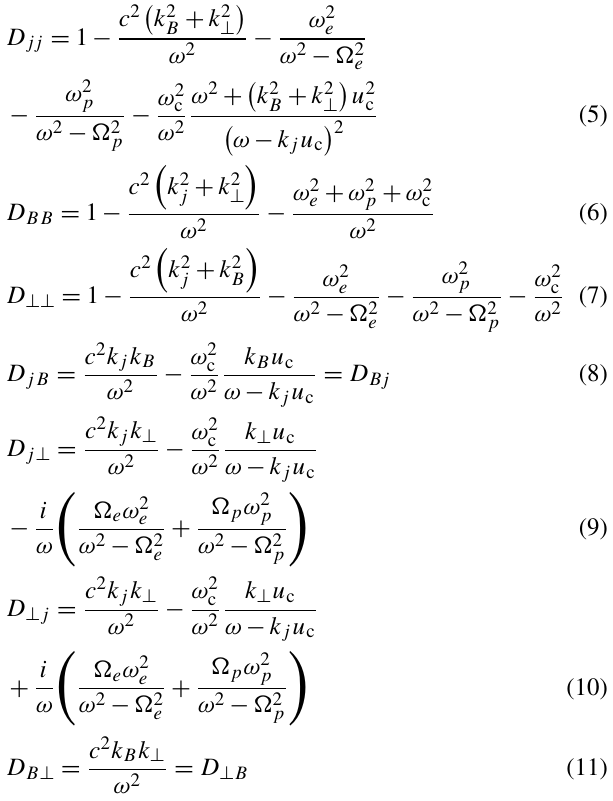
Table 1. List of plasma characteristics in the environment of P67/Churyumov-Gerasimenko at heliocentric distances of about 3AU (Hansen et al., 2007; Richter et al., 2015): the velocities are with respect to